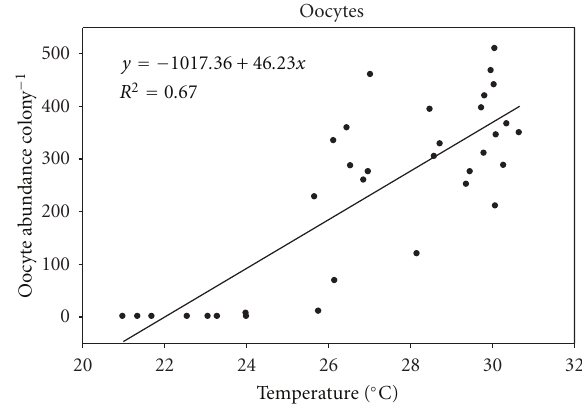
Figure 7: Simple regression of temperature and Solenastrea bournoni oocyte abundance, including all stages per colony at each sample date. R 2 = 0 . 67, P < 0 . 001.